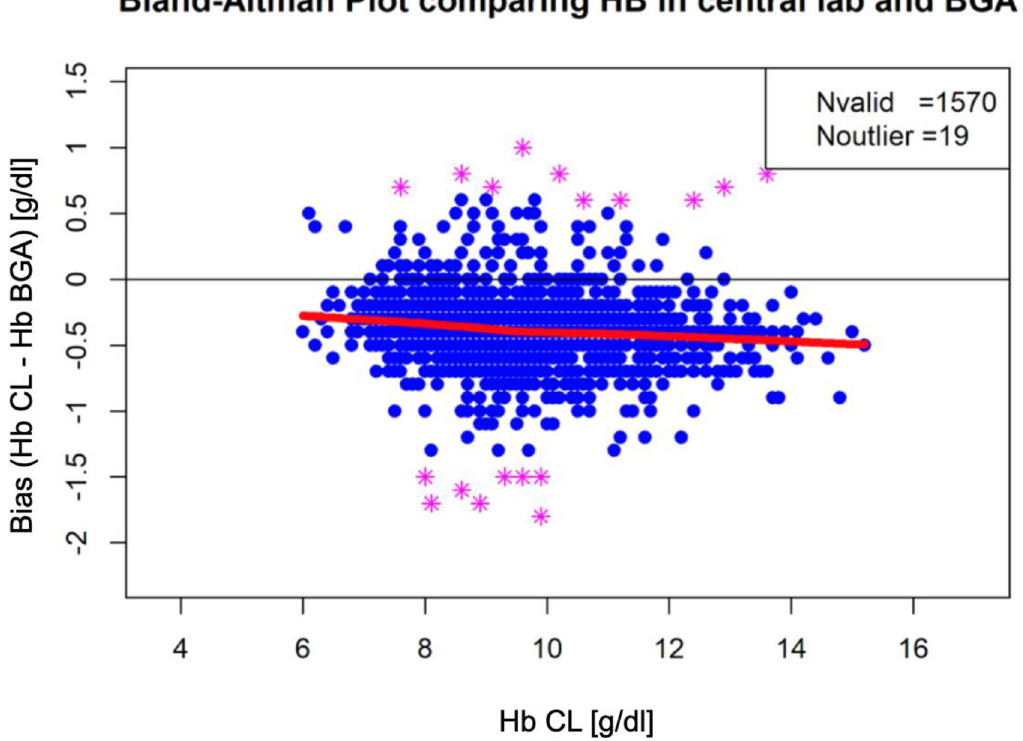
Fig 3. Bland-Altman Plot and LOWESS curve showing the differences of the Hb differences (LIB-07 and LIB-26). The difference of the Hb values (Hb-CL and Hb-BGA) calculated for each pair and plotted against the mean value of both measurements are displayed ((Hb-CL + Hb-BGA)/2). The LOWESS curve (red line) shows the tendency of mean bias with lower Hb levels. Hb = hemoglobin, CL = central lab, BGA = blood gas analysis.